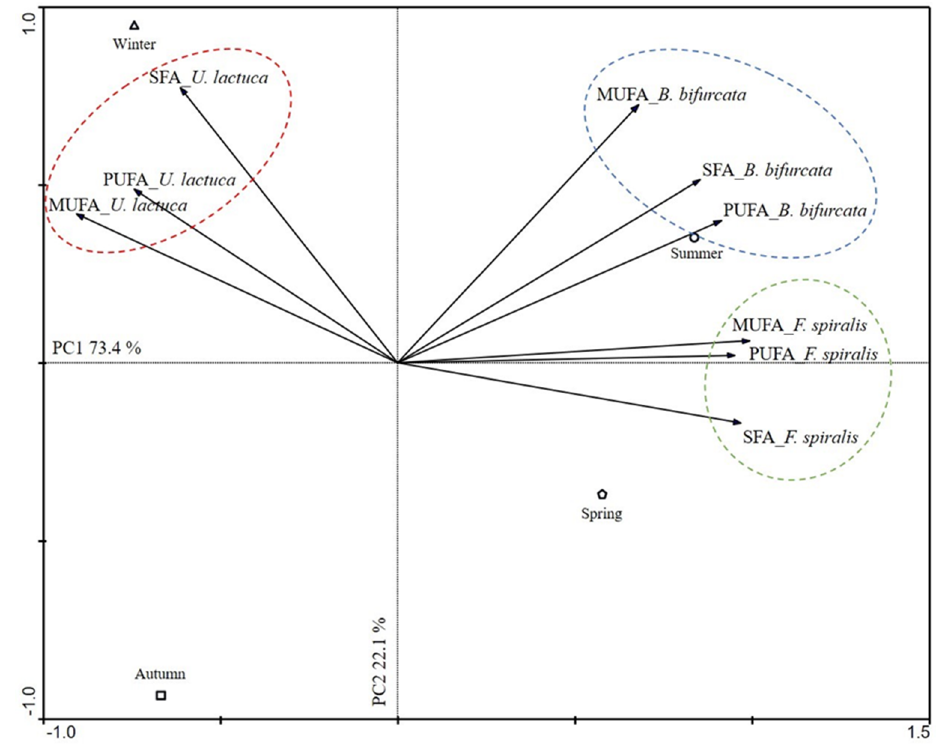
Figure 2. Biplot diagram from principal component analysis (PCA) relating the classes of FA (SFA, MUFA, and PUFA) present in Ulva lactuca , Bifurcaria bifurcata, and Fucus spiralis in different seasons (winter, spring, summer, and autumn).